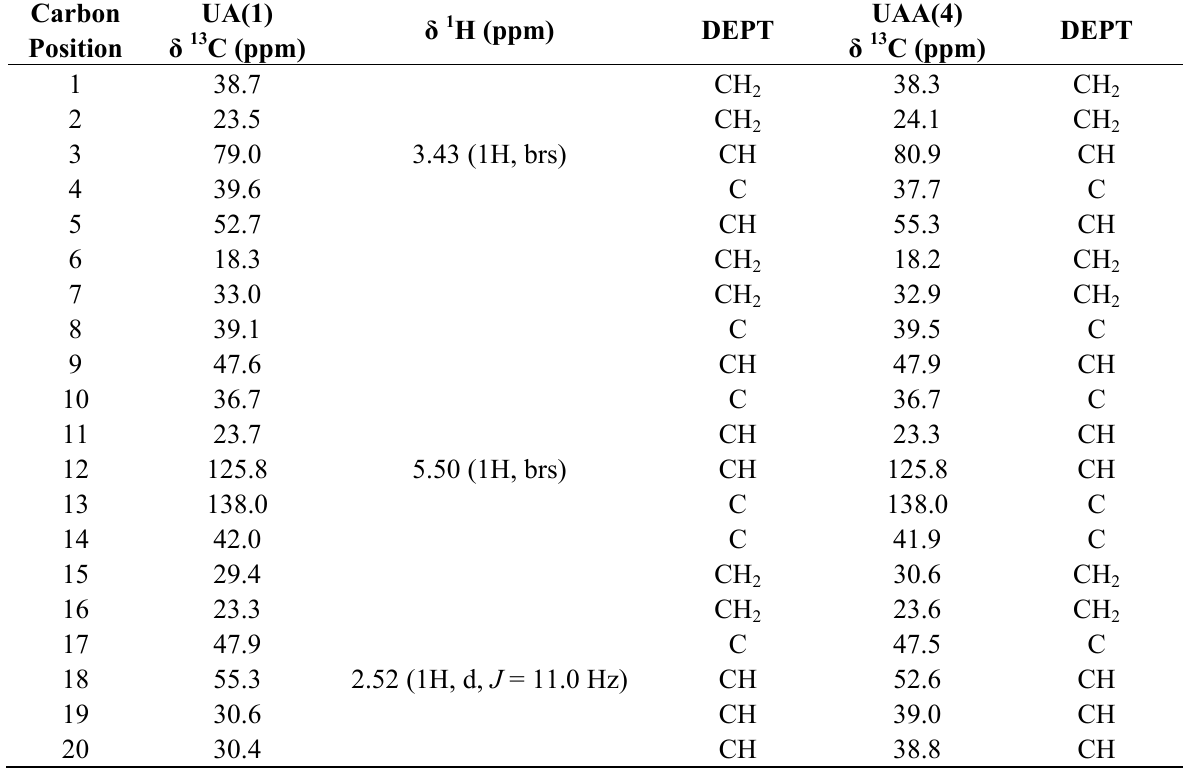
Table 2. 1 H- and 13 C-NMR chemical shifts ( δ , ppm) of compounds 1 , 4 and 2